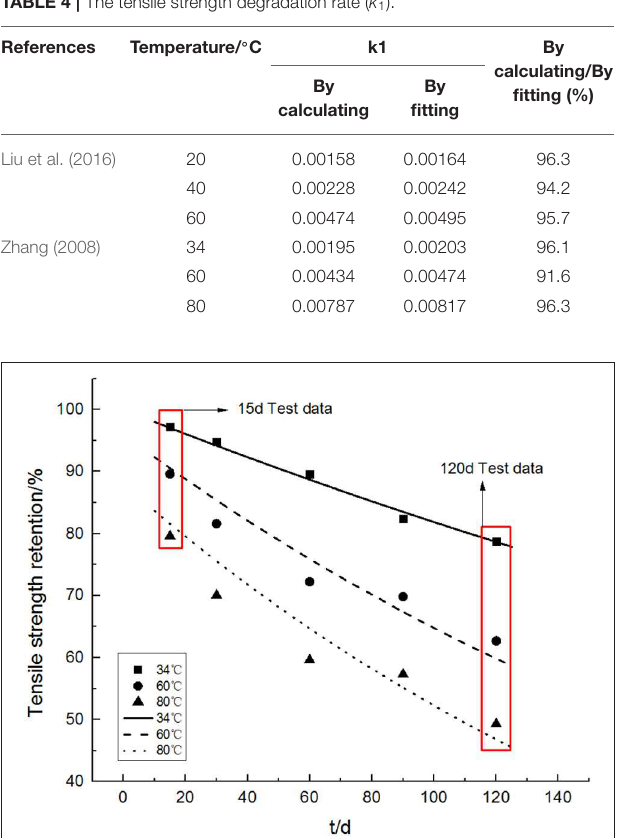
(4) Due to the diversity of GFRP rebar type, the